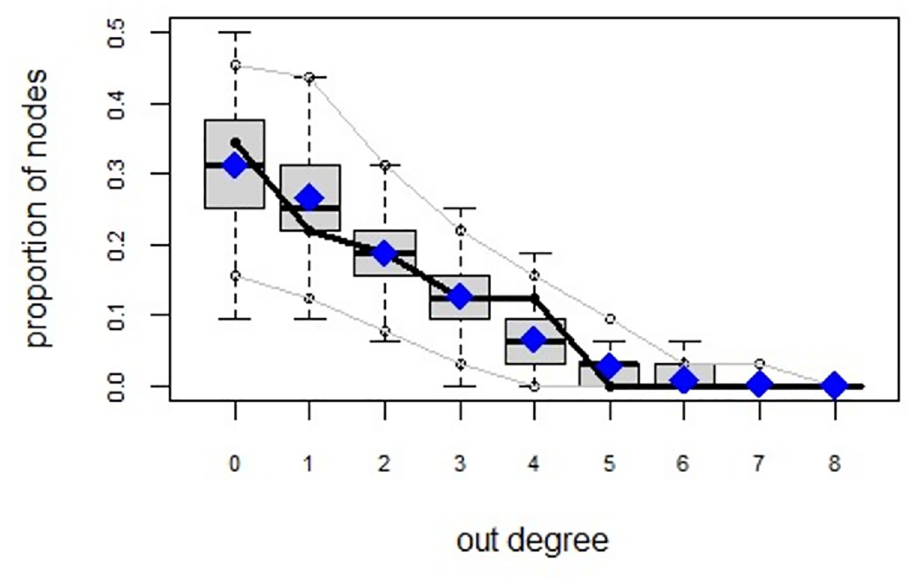
Fig 9. Multiplexity in the alpha community—goodness of fit [24] out degree.